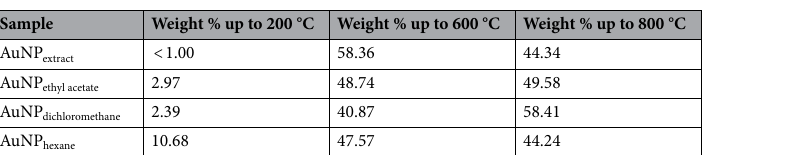
Table 3. Weight loss percentage of the AuNPs.